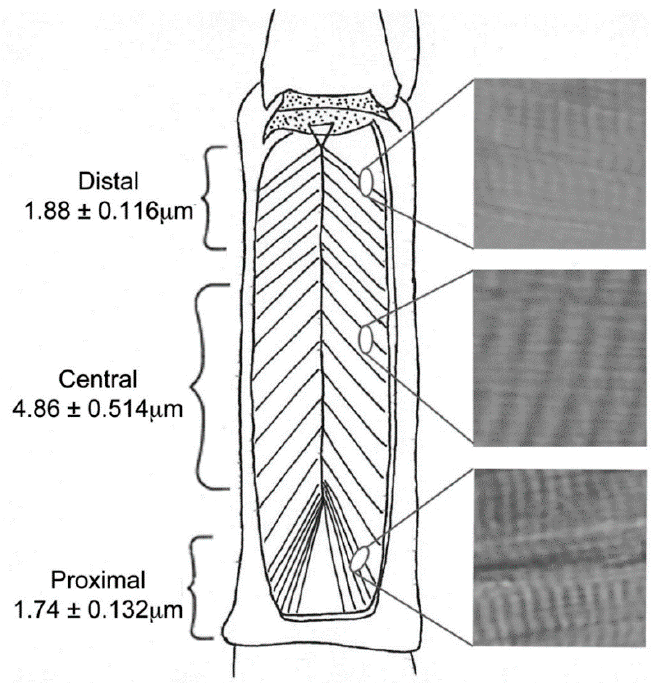
Figure 9. Sarcomere lengths: The sarcomeres of each of the three regions were passively stretched by pushing the claws of 5 different legs closed. Each region was measured 5 times in each preparation for a total of 25 measurements. Highlighted to the right of this figure are sample photographs. The central region had larger sarcomeres than the proximal or distal.